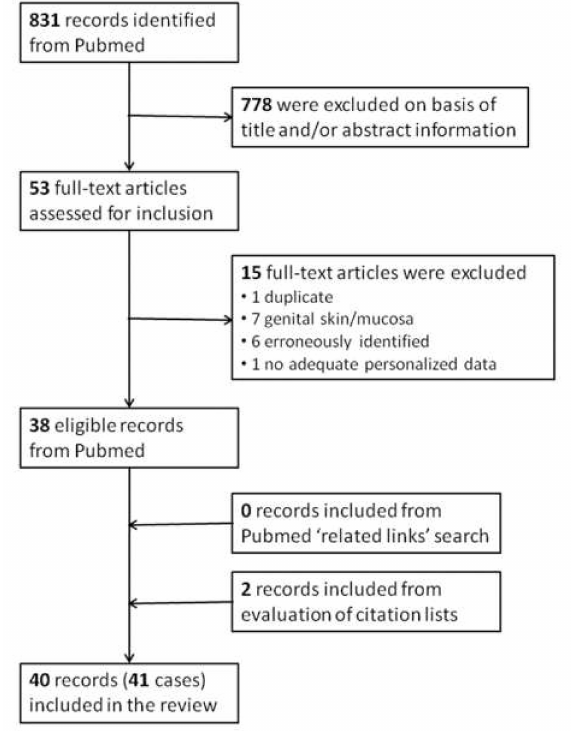
Figure 1. Literature search: Flowchart of publicationsrelated to PNS cases in keratinocyte skin cancers selection process. Table 1. Characteristics of patients with a keratinocyte skin cancer associated with paraneoplastic